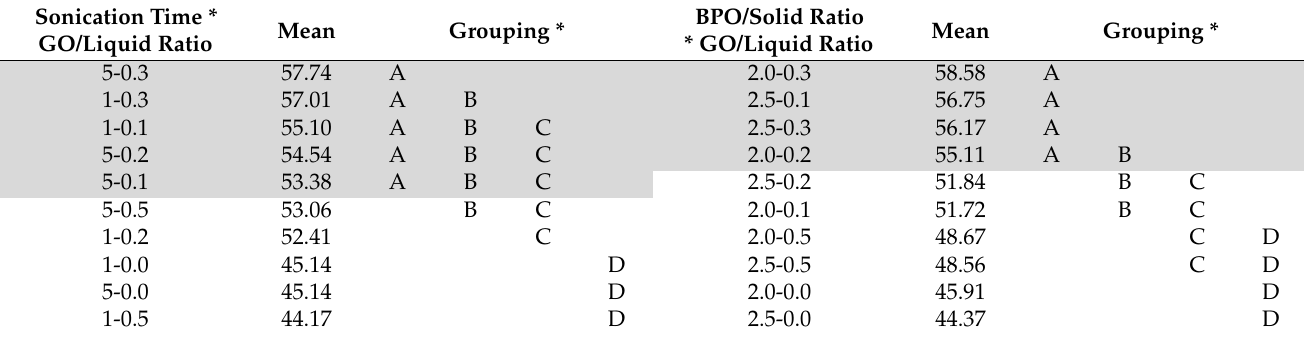
Table 6. Grouping information for bending strength using Tukey’s test and 95% confidence.